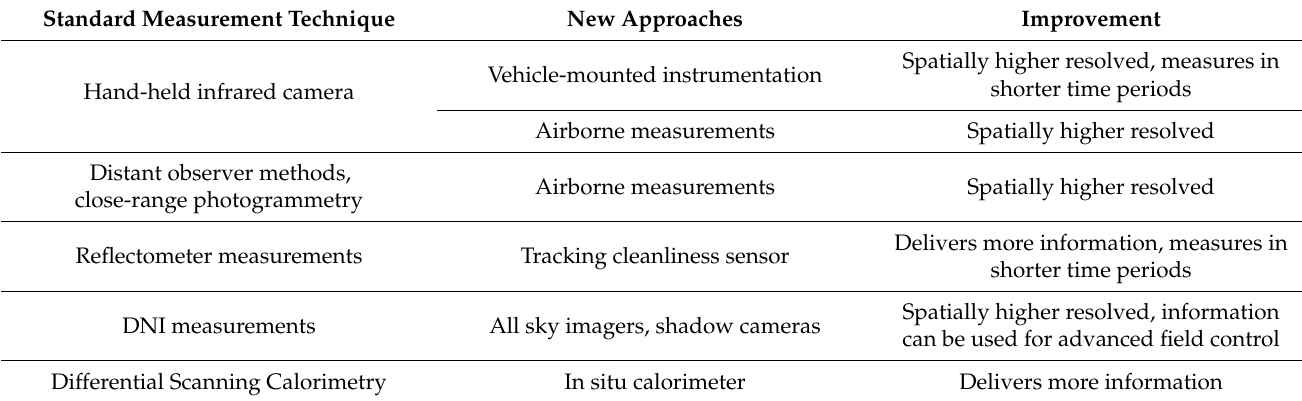
Table 6. Direct comparison of standard measurement techniques and new approaches in collector field monitoring. Standard Measurement Technique New Approaches Improvement Spatially higher resolved, measures in Vehicle-mounted instrumentation shorter time periods Hand-held infrared camera Airborne measurements Distant observer methods, Airborne measurements close-range photogrammetry Reflectometer